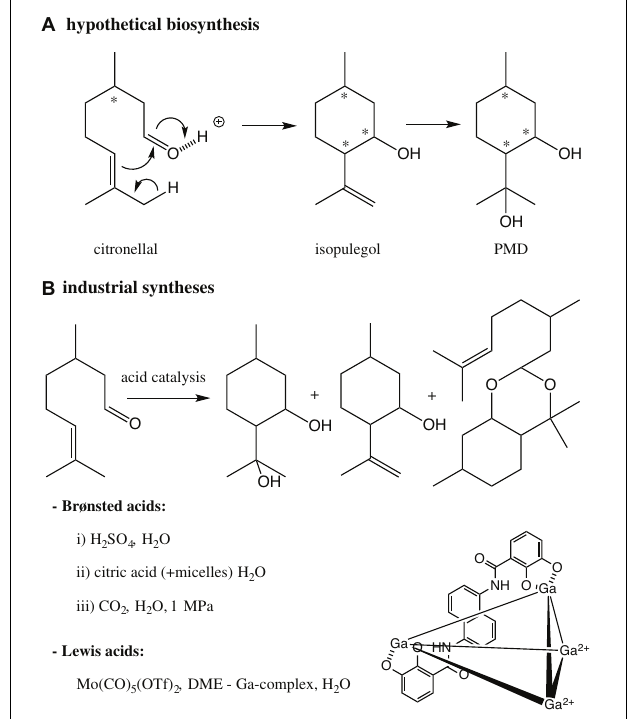
SCHEME 5 | (A) Hypothetical biosynthesis of PMD in plants enriched in citronellal; (B) bio-inspired industrial syntheses of PMD catalyzed by Brønsted or Lewis acids. * asymmetric